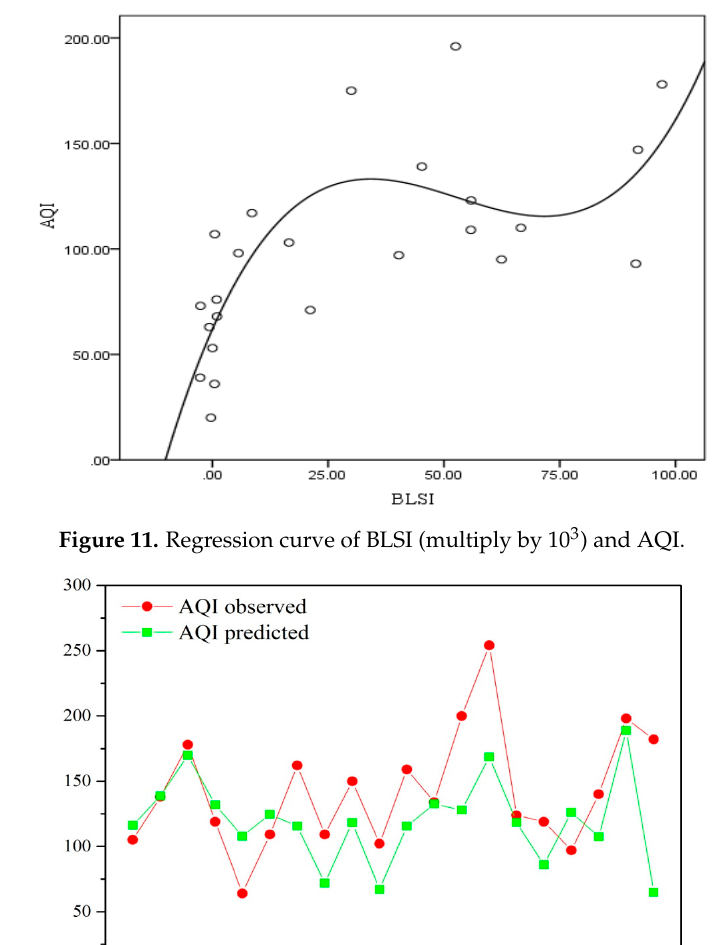
Figure 12. Prediction ability test of nonlinear regression equation.